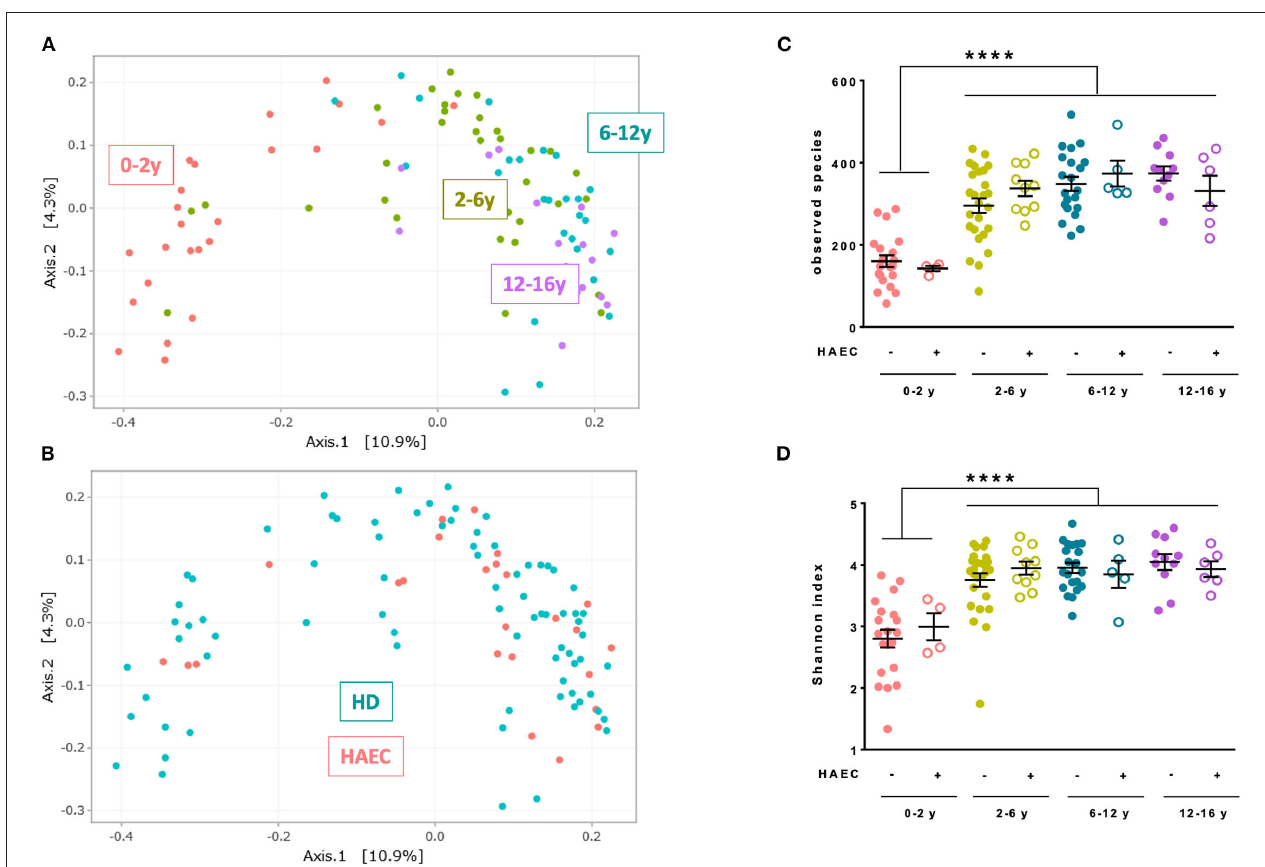
FIGURE 3 | Characteristics of fecal microbiota of the MICROPRUNG cohort. Principal coordinates analysis representation of Jaccard distance between fecal microbiota highlighting age group (A) or Hirschsprung-associated enterocolitis status (B) . Number of observed species (C) and Shannon index (D) of the microbiota in function of age group and Hirschsprung-associated enterocolitis status. **** P <